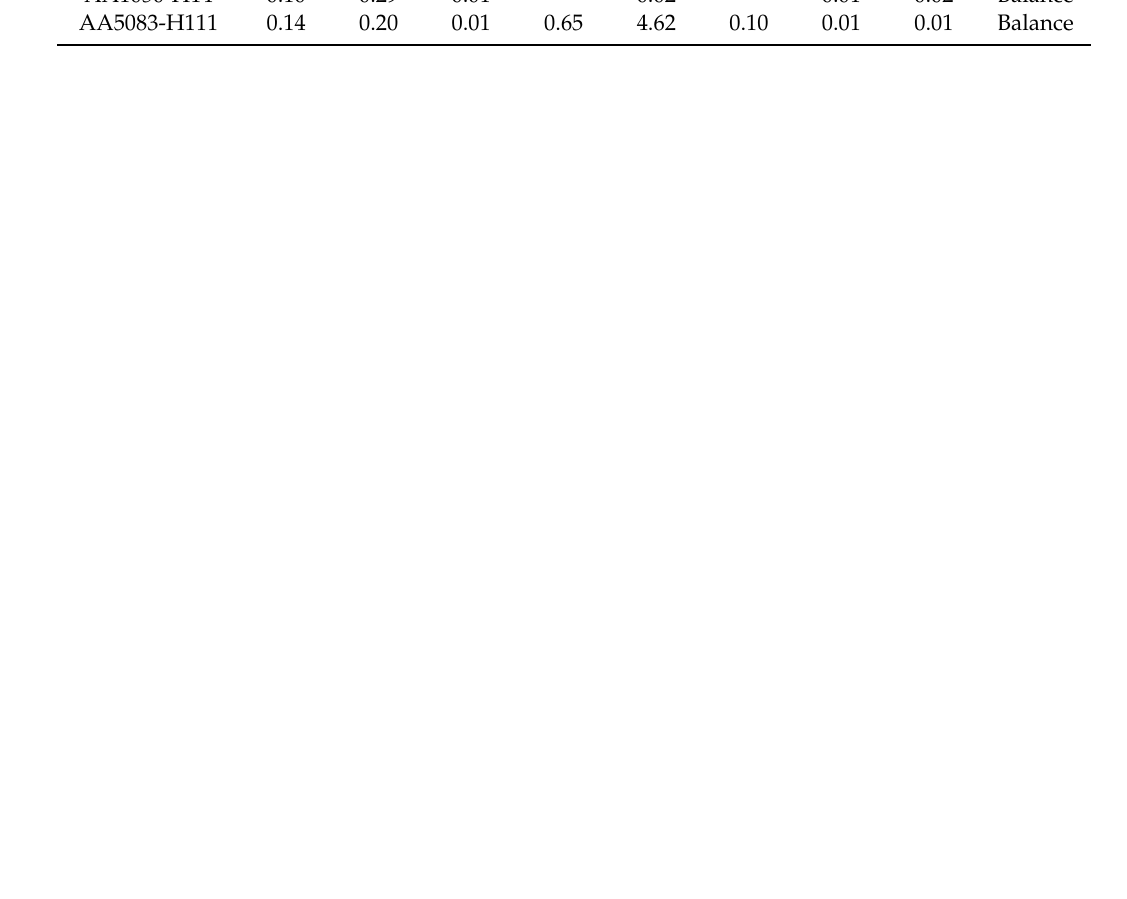
Table 2. Chemical composition of AA1050-H14 and AA5083-H111 (wt.%) [16,21,27].